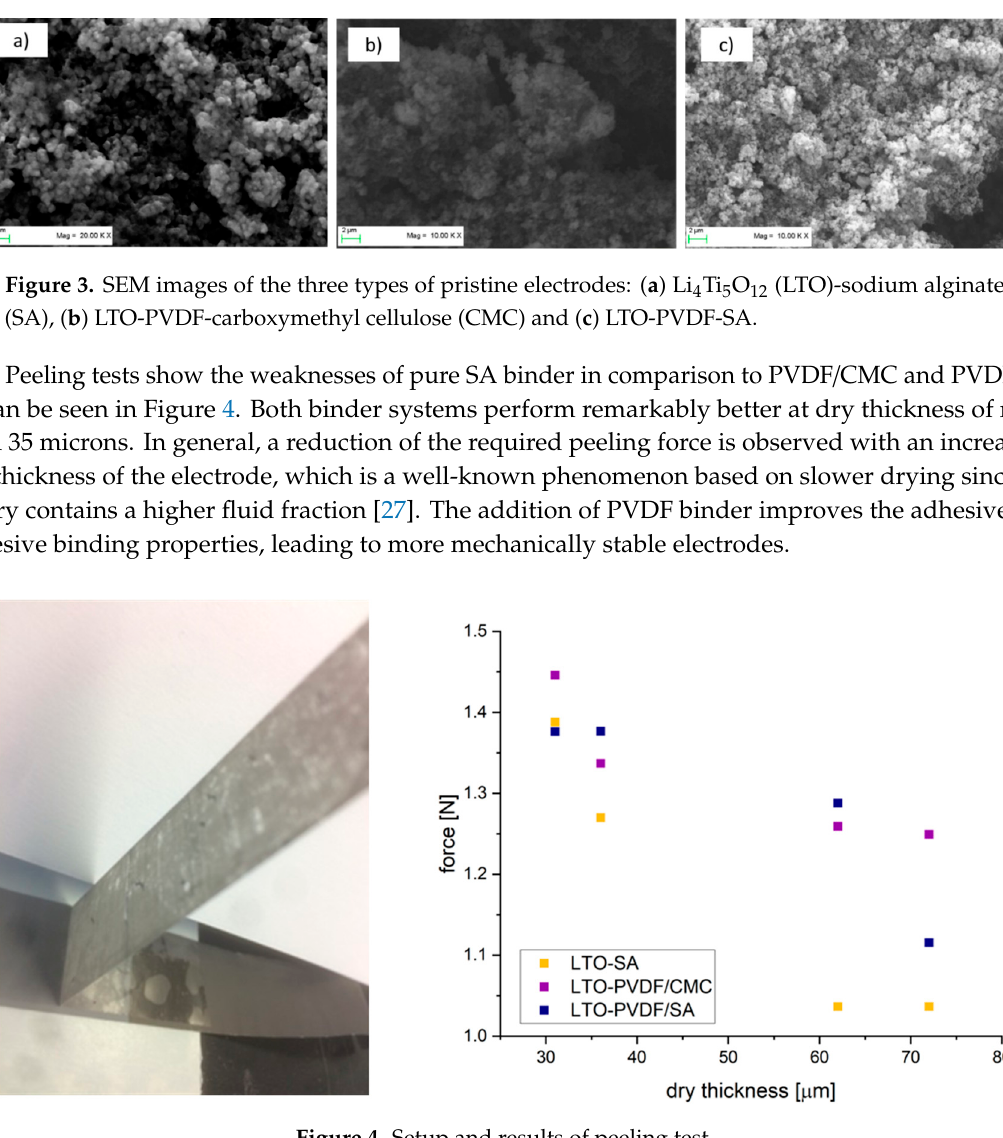
Figure 4. Setup and results of peeling test.